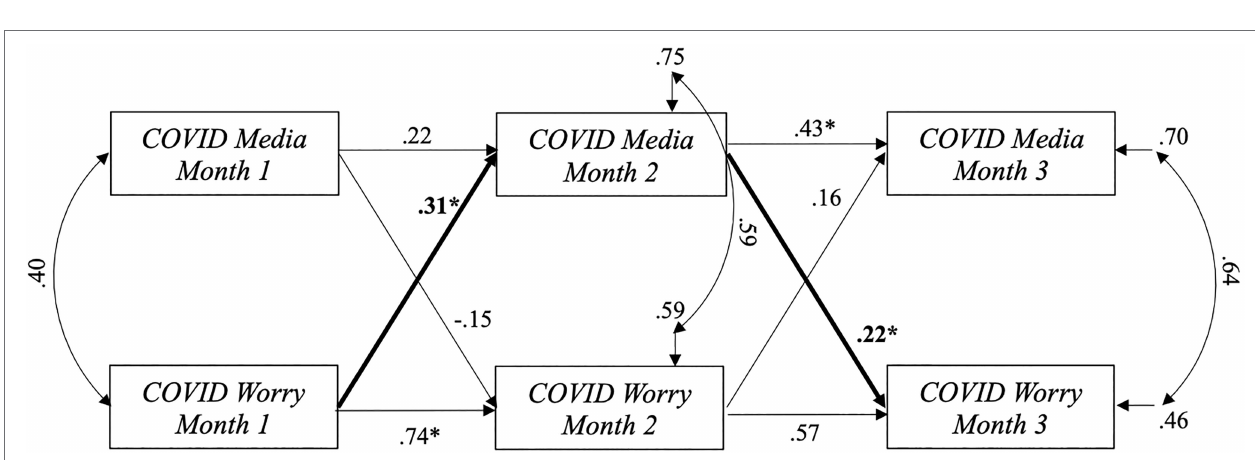
FIGURE 2 | Lagged associations between pandemic-related media consumption and worry over three-month period. * p < 0.05. Standardized coefficients are shown. Bolded pathways represent significant cross-lagged associations. = R 0.30 2